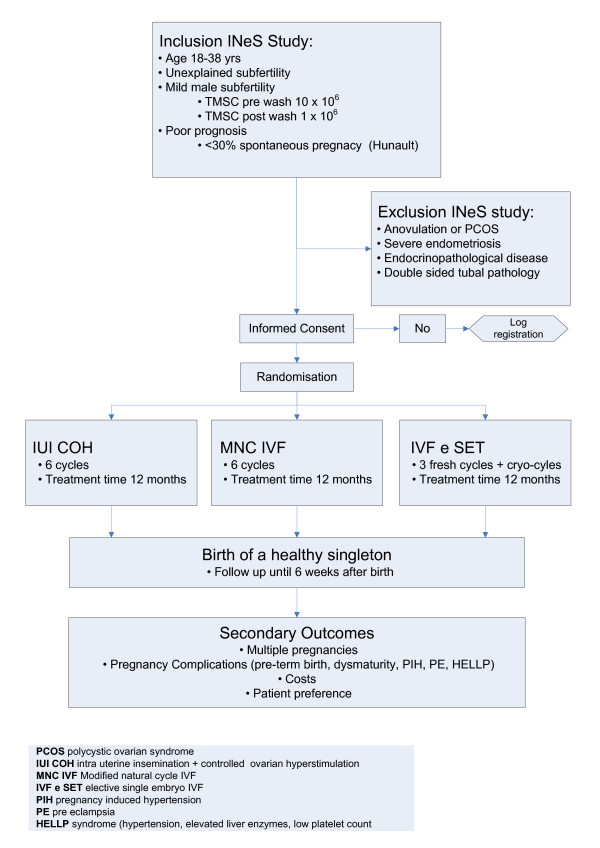
Flowchart of study.